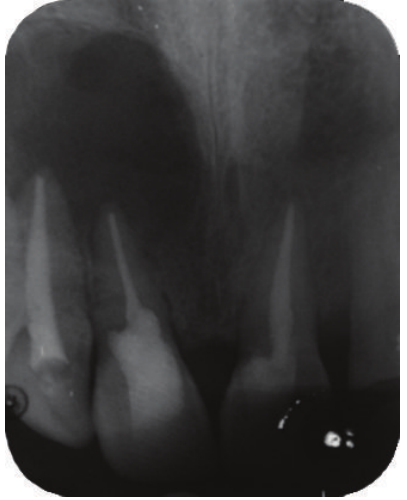
Figure 8: Postobturation IOPA radiograph.